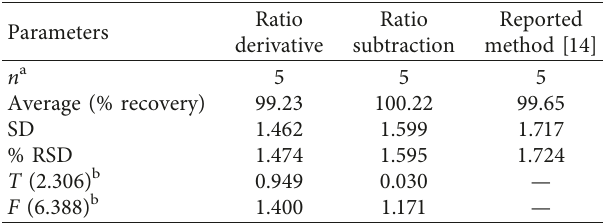
a Number of measurements; b The values in parenthesis are tabulated values of “ t ” and “ F ” at ( P � 0 . 05). Table 5: One-way ANOVA testing for the different proposed methods used for the determination of aclidinium bromide in Duaklir Genuair inhalation powder.